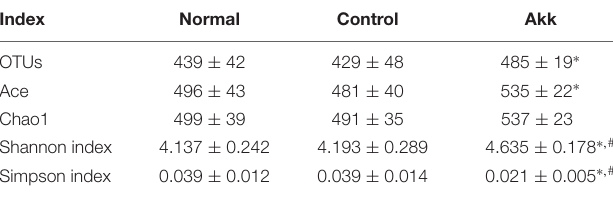
TABLE 2 | Richness and diversity of fecal microbiota among